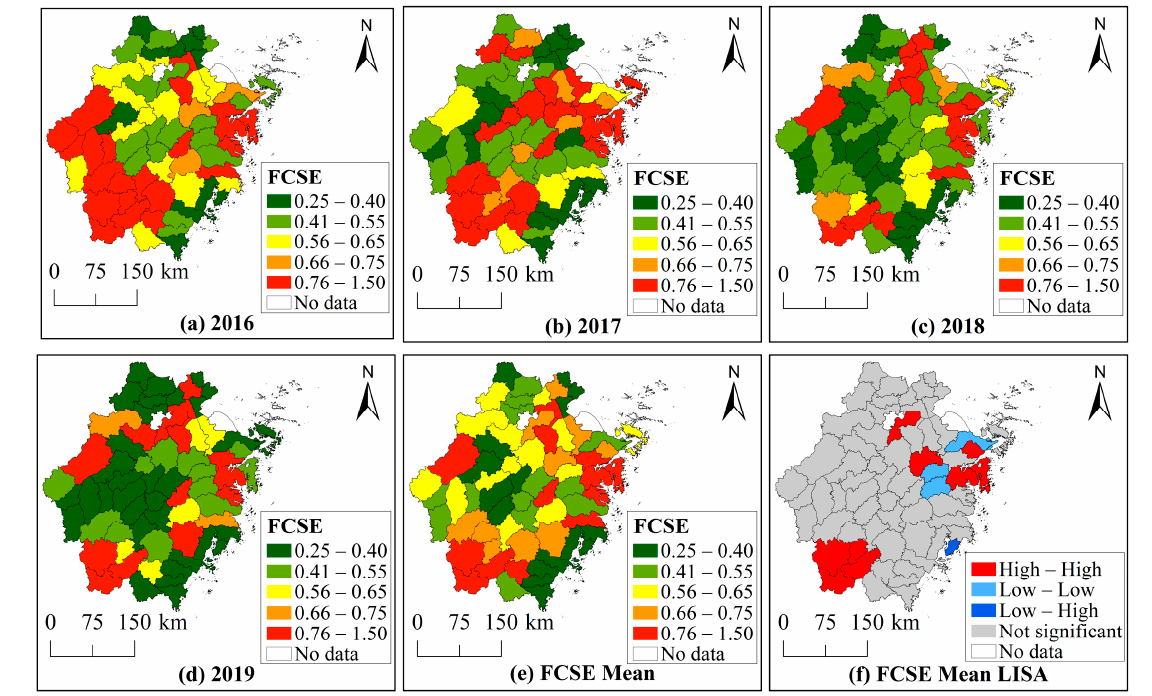
Figure 3. Spatiotemporal characteristics of county forest carbon sequestration efficiency in Zhejiang Province from 2016 to 2019.